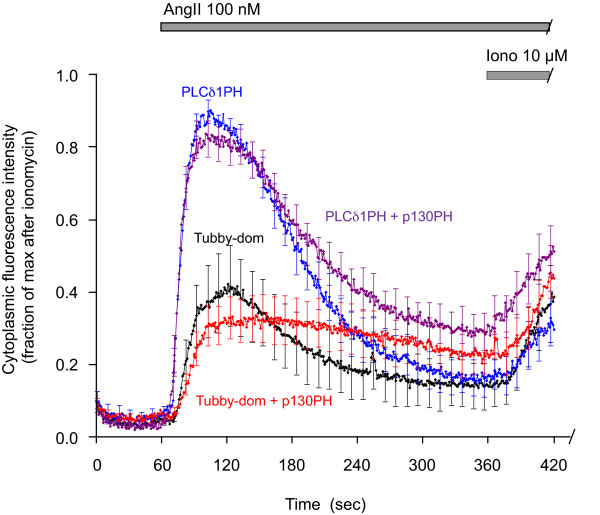
Effects of InsP3 buffering on AngII-induced Tubby-domain and PLCδ1PH translocation responses. HEK293-AT1 cells were transfected with the indicated GFP reporter constructs alone or together with p130PH-mRFP. After 24 hours, cells were examined in a Zeiss Live 5 DuoScan confocal microscope at room temperature. Cells were stimulated with 100 nM AngII at 60 second followed by 10 μM ionomycin at 360 sec. Data were collected at 1 fps rate and the cytoplasmic fluorescence intensity was analyzed in selected regions of interest outside the nucleus. Values were normalized for minimum and maximum fluorescence values for each run and these values were averaged. Means ± S.E.M. are shown obtained from: n = 10 (Tubby domain alone), n = 12 (PLCδ1PH alone), n = 21 (Tubby domain + p130PH-mRFP) and n = 20 (PLCδ1PH + p130PH-mRFP) cells. The traces were truncated at 420 sec to better illustrate the AngII-induced changes.